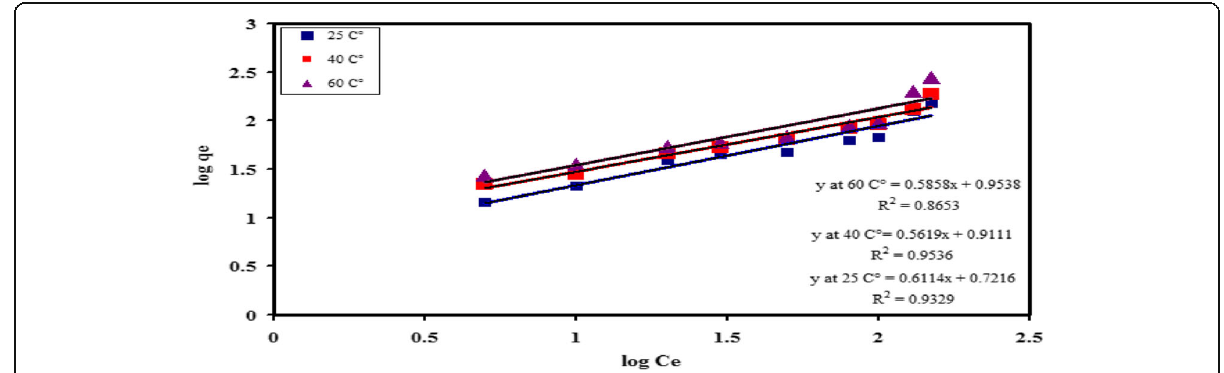
Fig. 17 Freundlich isotherm model